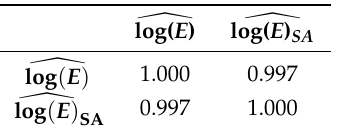
(cid:92) . log ( E ) SA